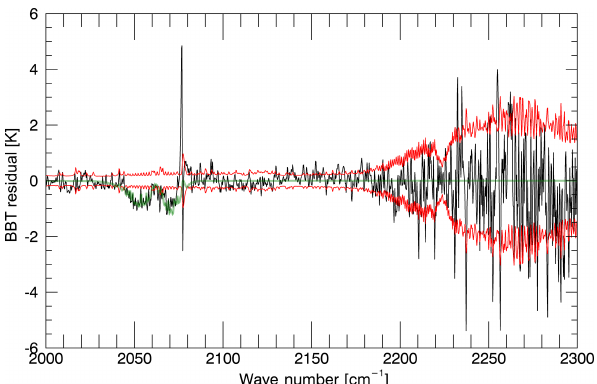
Figure 5. The residual spectrum between the IASI observation and the converged estimate from the RFM without modelling OCS is shown as the black line. The red line depicts the instrument noise level specific to the observed surface temperature of 281K and at- mospheric temperature profile. The green line represents the ex- pected OCS signal in the residual for the retrieved VMR of 404ppt.